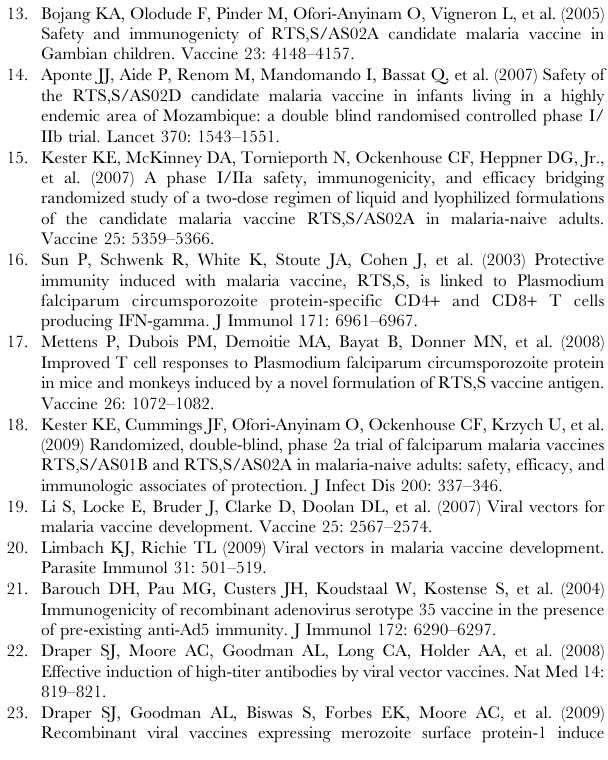
Protocol S1 Clinical protocol for NMRC-M3V =Ad-PfCA